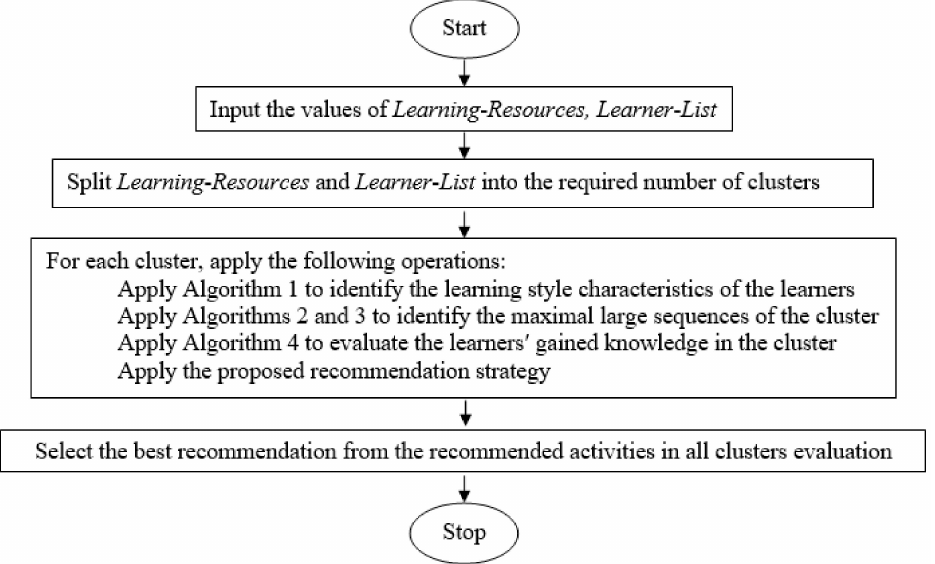
Figure 7. The proposed cluster-based intelligent hybrid recommender.